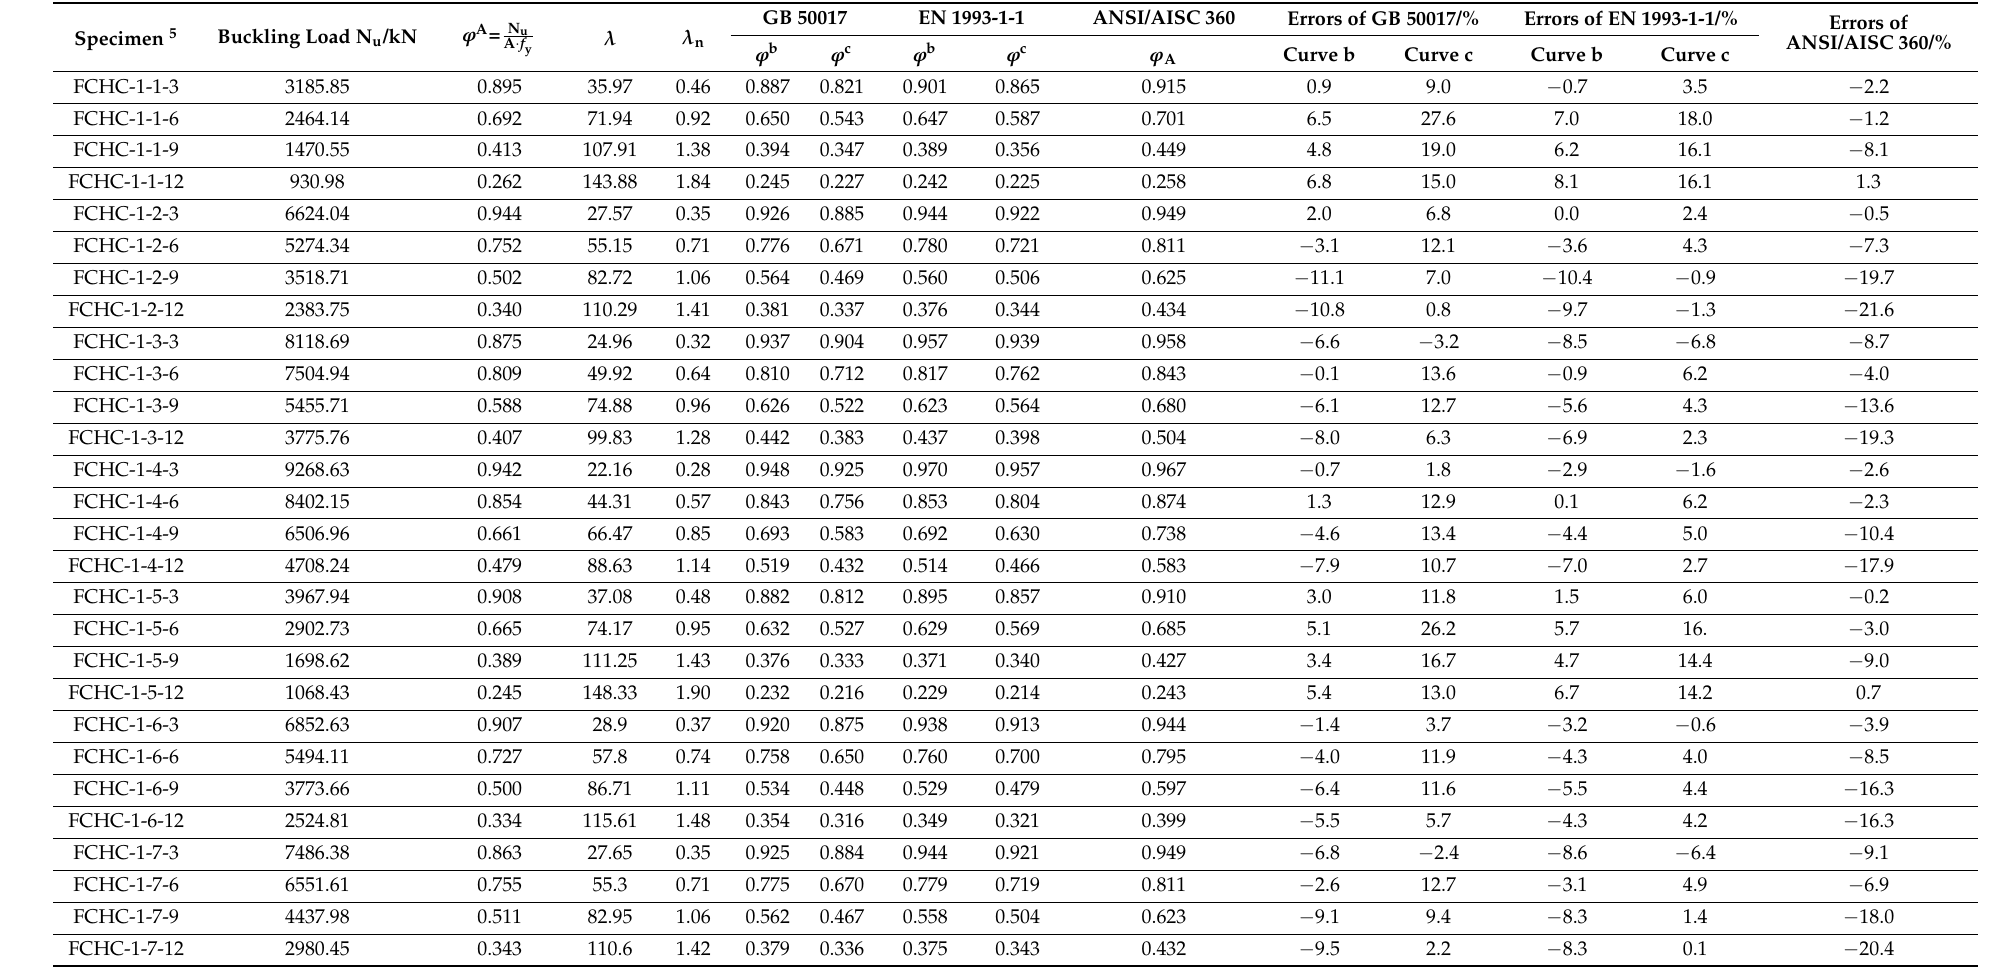
Table 7. Buckling resistance for Q345 specimens with comprehensive imperfections of Curve b in Table